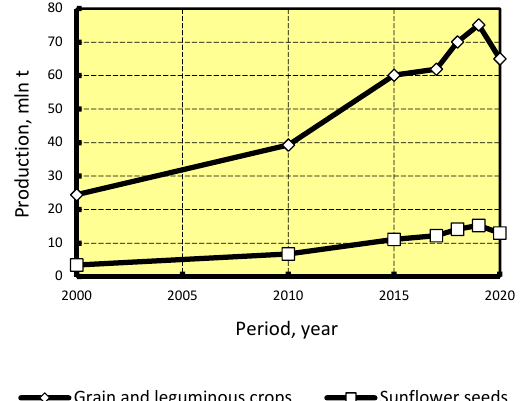
Figure 3. Grain and sunflower seed production history.